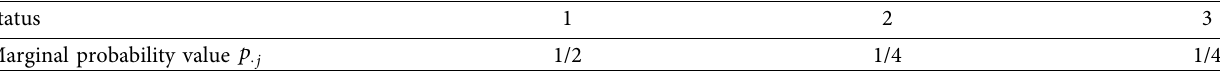
Table 3: Marginal probability